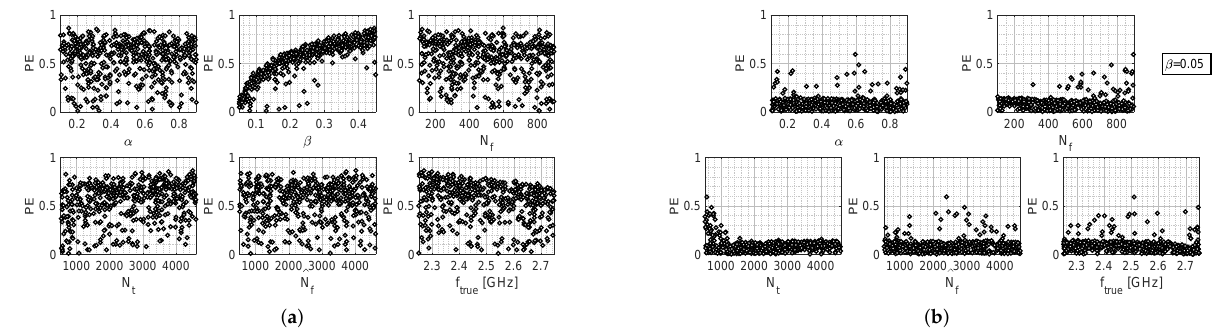
Figure 4. Performance evaluation of the MUSIC-based algorithm: ( a ) scatter plots between PE and the various setting parameters, when the latter are all uniform random variables; ( b ) scatter plots between PE and the various setting parameters, when β = 0.05 and all other parameters are uniform random variables.